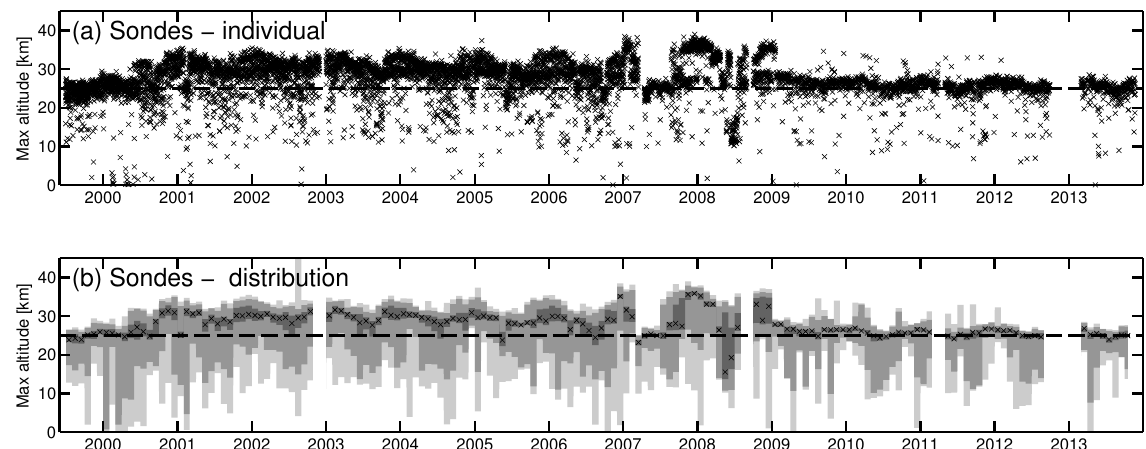
Figure 2. Maximum heights reached by radiosondes. Panel (a) shows a cross for each individual sonde. In (b) each column shows the distribution of maximum heights for the corresponding month, with colours indicating (in order of increasing saturation) the full range, 5th–95th percentile, and 32nd to 68th percentiles of maximum heights reached by that data set in that month. Crosses indicate the monthly median. One sonde extends above the figure axis (August 2003); this balloon reported a maximum altitude of ∼ 60km. Horizontal dashed lines indicate the required minimum height for a measurement to be included in our